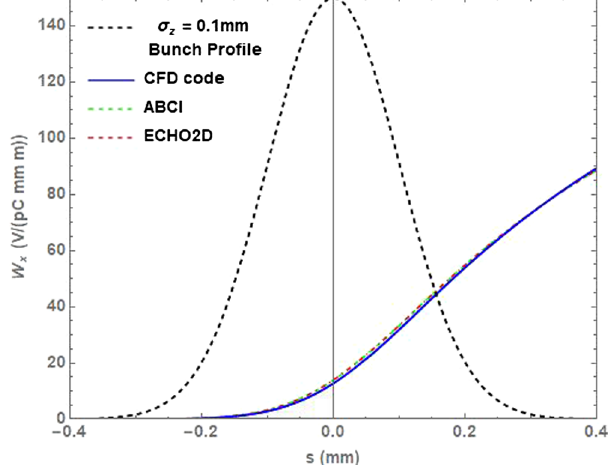
FIG. 36. A comparison of the short-range transverse bunch wake for cell D of the XARA design as calculated by the Complex Frequency Domain code (CFD) (solid blue), ABCI (dashed green) and ECHO2D (dashed red). The Gaussian bunch profile in arbitrary units is also shown (dashed,